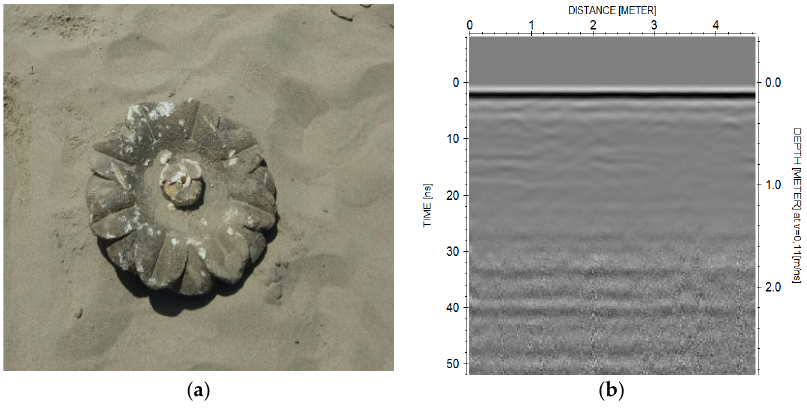
Figure 10. ( a ) Image of a rock, ( b ) radargram obtained.